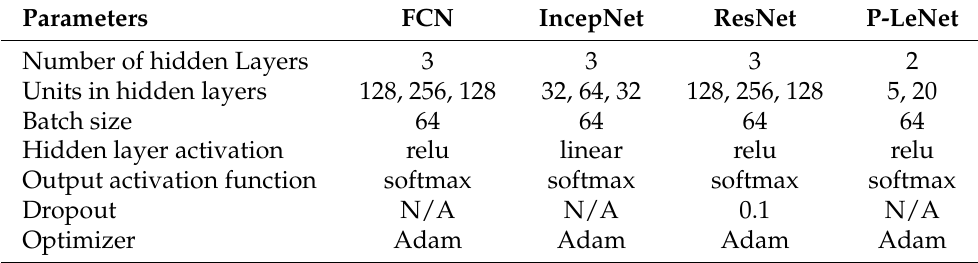
Table 5. The hyper-parameters of the selected DTL models.